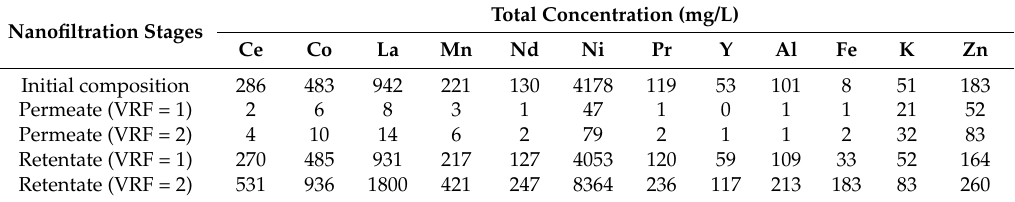
Table 8. Concentration of individual elements after separation of acid by nanofiltration in experiment N1.